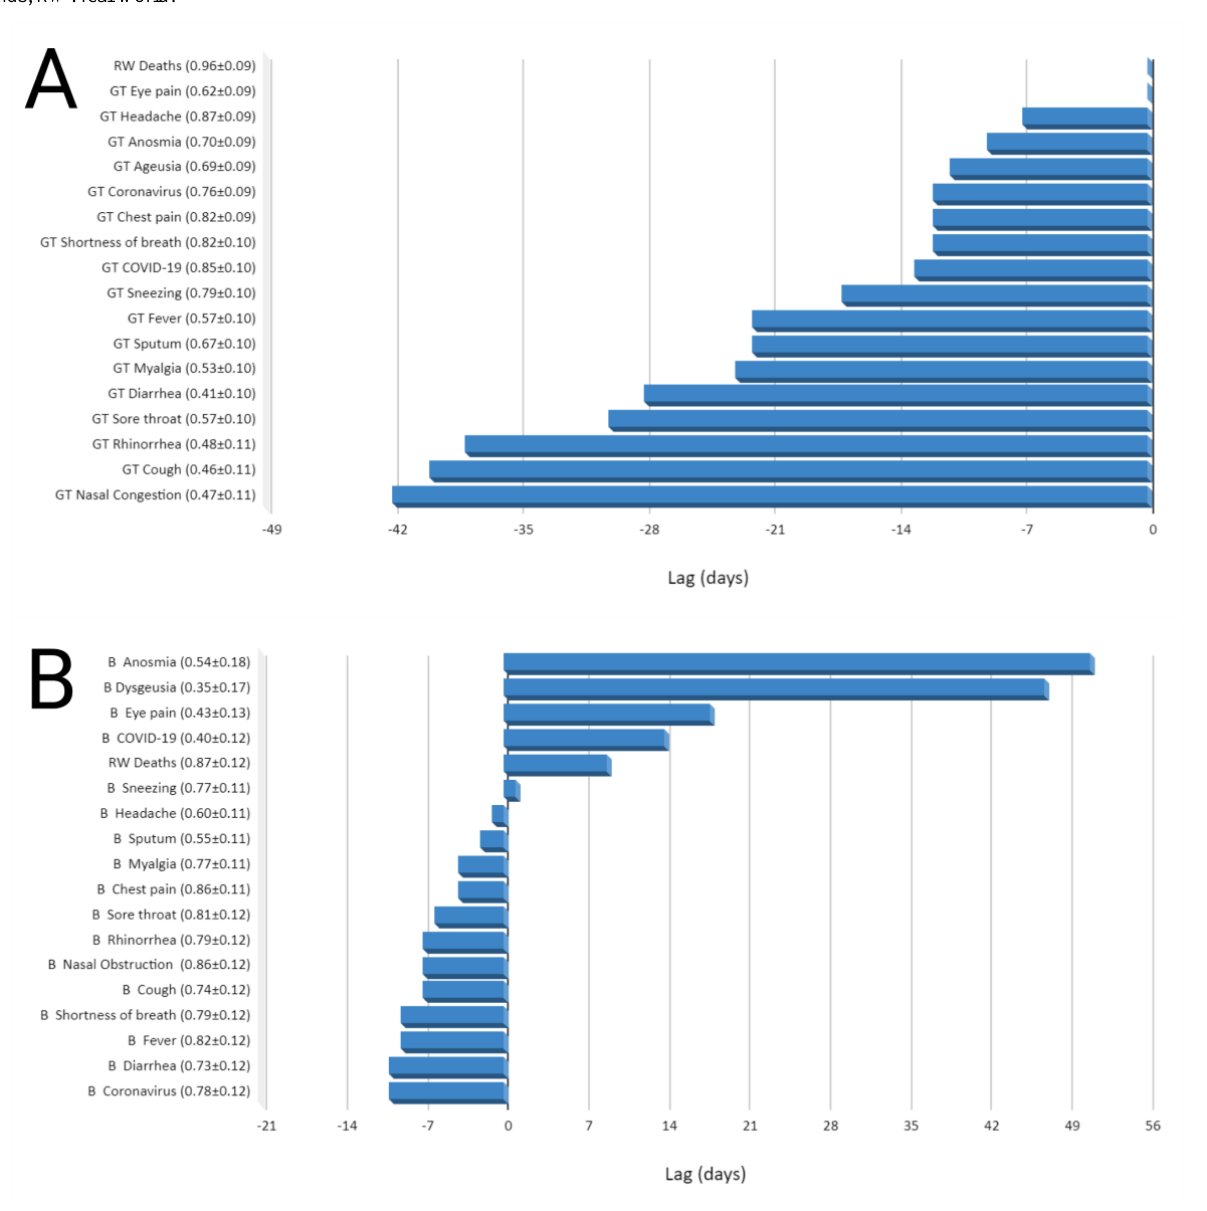
Figure 6. Lag correlations of online search terms worldwide to RW COVID-19 daily cases from January 9, 2020, to April 6, 2020. Note that a negative lag time means online searches preceded the daily RW cases. In parenthesis next to each search term is r±SE. (A) Lag-time of GT search terms, including GT coronavirus (virus), GT COVID-19 (search term), symptom term searches, and RW deaths compared to RW confirmed COVID-19 cases worldwide. (B) Lag time of Baidu Index search terms, including Baidu Index coronavirus (search term), Baidu Index COVID-19 (search term), symptom term searches, and RW Chinese deaths compared to RW confirmed COVID-19 cases in China. B: Baidu Index; COVID-19: coronavirus disease; GT: Google Trends; RW: